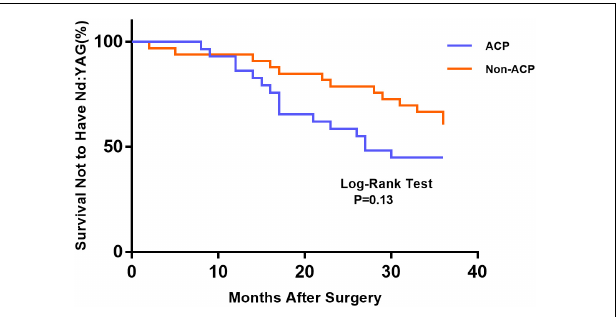
FIGURE 1 | Kaplan–Meier survival plots for eyes by surgical treatment (Nd:YAG, neodymium:YAG laser capsulotomy; ACP, anterior capsule polishing).